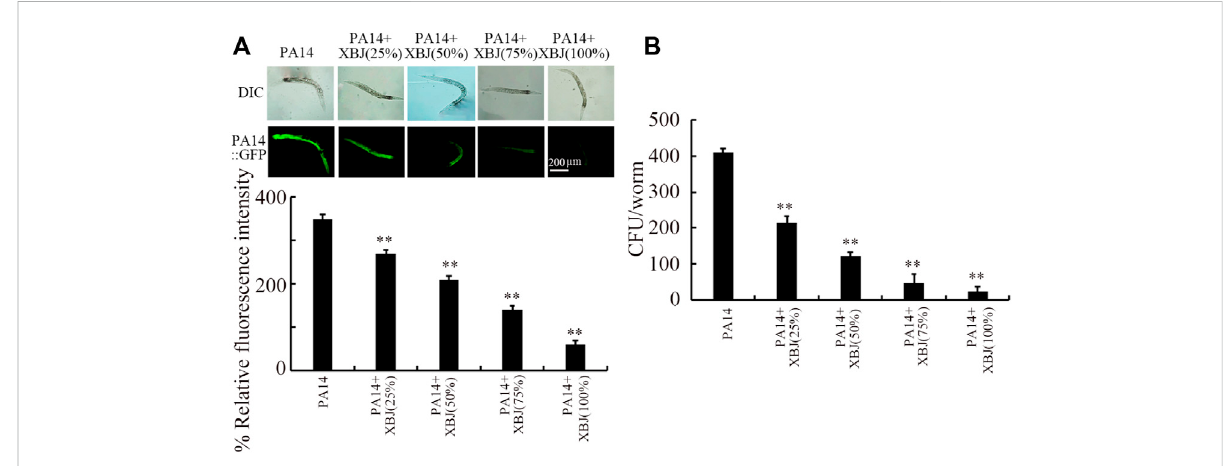
FIGURE 2 Effect of Xuebijing post-treatment on PA14:GFP (A) and CFU (B) in P . aeruginosa -infected nematodes. XBJ, Xuebijing. ** p < 0.01 vs.